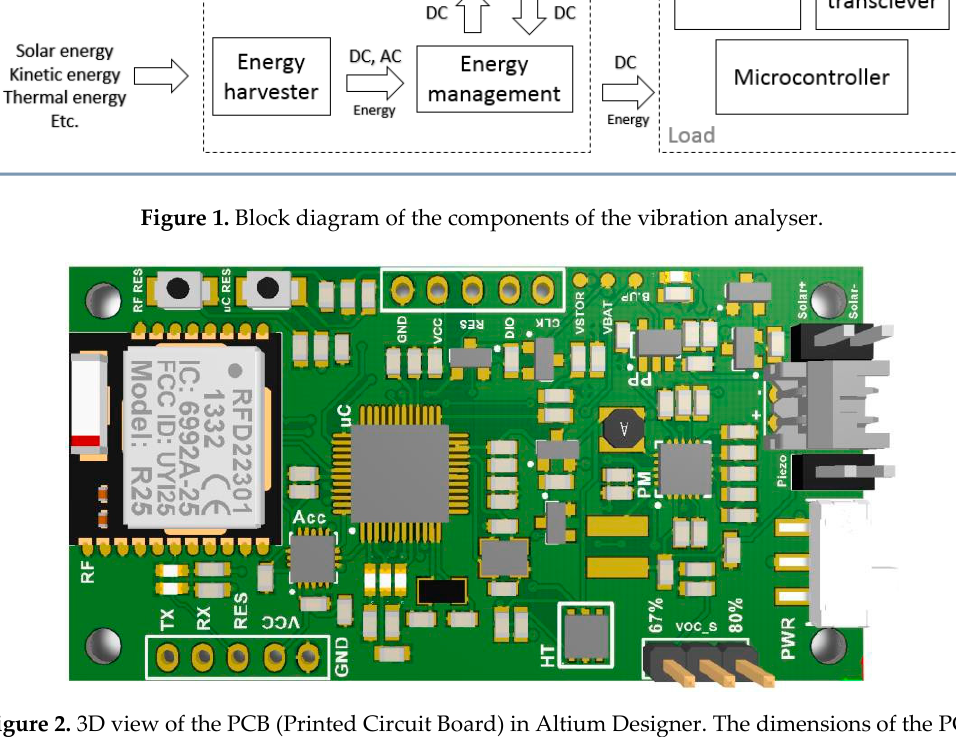
Figure 2. 3D view of the PCB (Printed Circuit Board) in Altium Designer. The dimensions of the PCB is 57.5 × 30